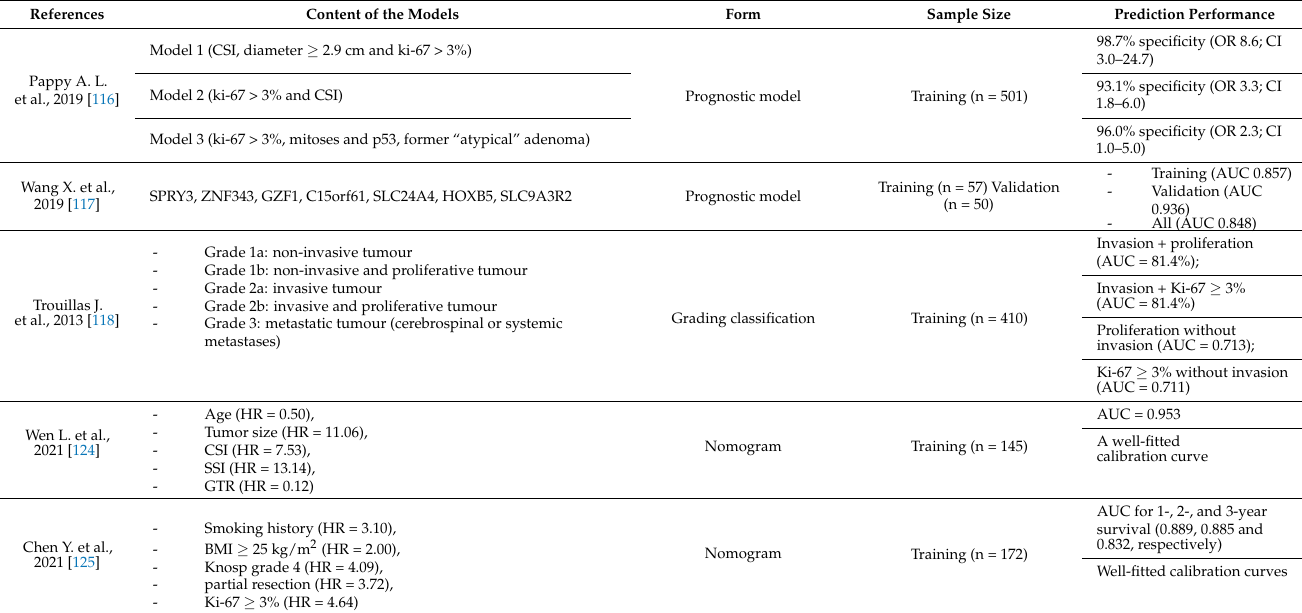
Table 1. Summary of recent studies on comprehensive model for predicting the recurrence of pituitary